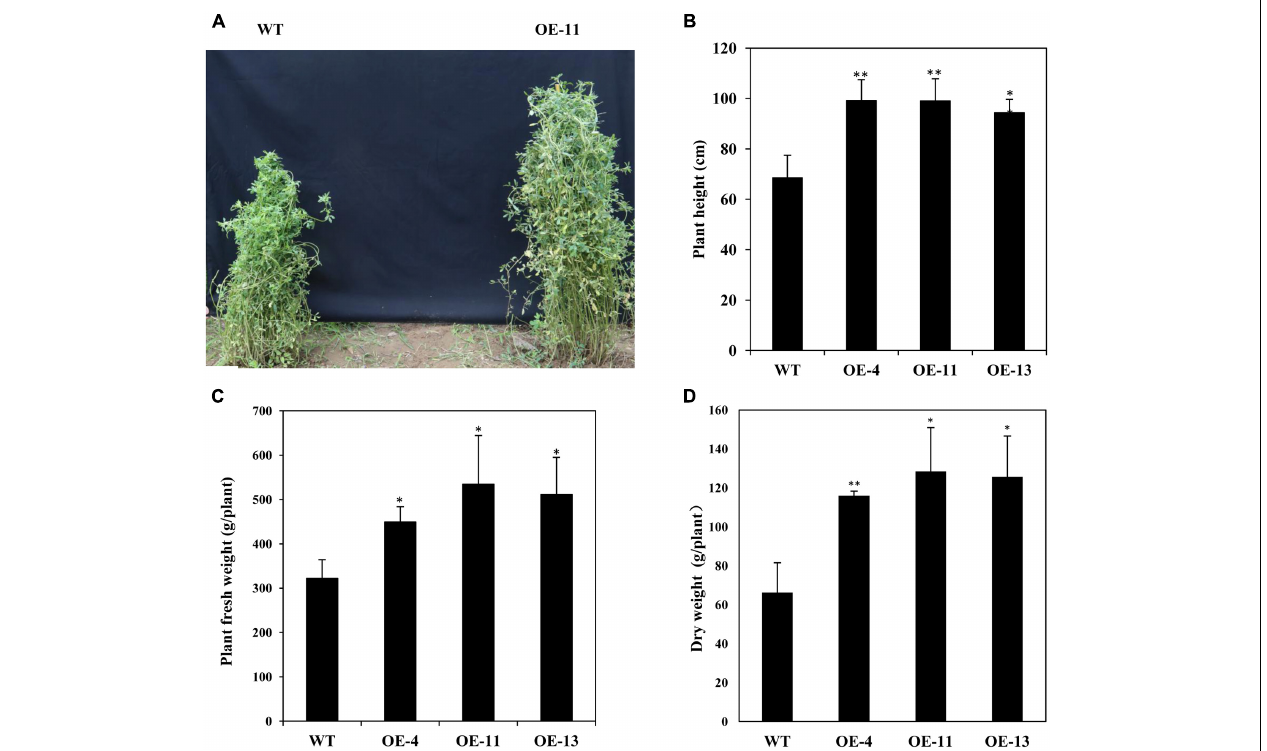
FIGURE 9 | Growth of wild type and transgenic alfalfa plants in a field trial during the second year. (A) Phenotype comparison of wild type (left) and transgenic (right) plants in field trial during the second year. (B) Shoot height of wild type and transgenic plants at second year in field trial. (C,D) Fresh weight (left) and dry weight (right) of wild type and transgenic alfalfa plants. Values are means ± SD of three replicates ( ∗ P < 0.05, ∗∗ P <